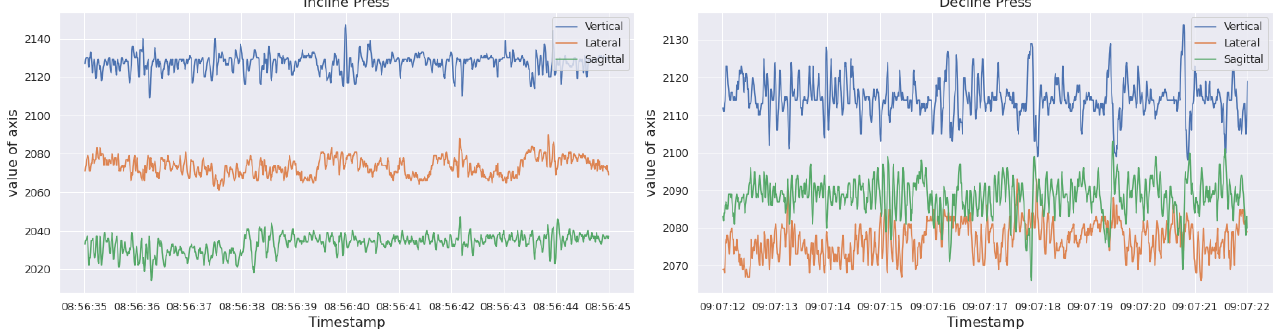
Figure 2. Visual inspection of acceleration data for incline press and decline press activity from chest